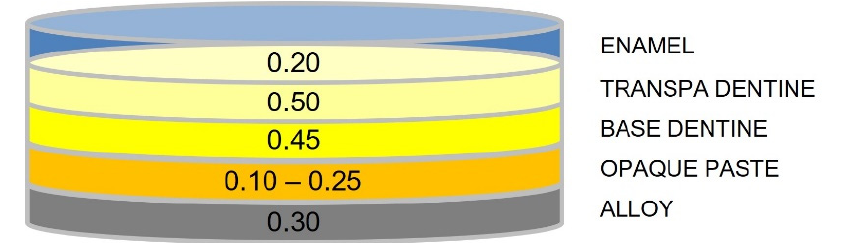
Figure 1. Specimen configuration (dimensions in mm).